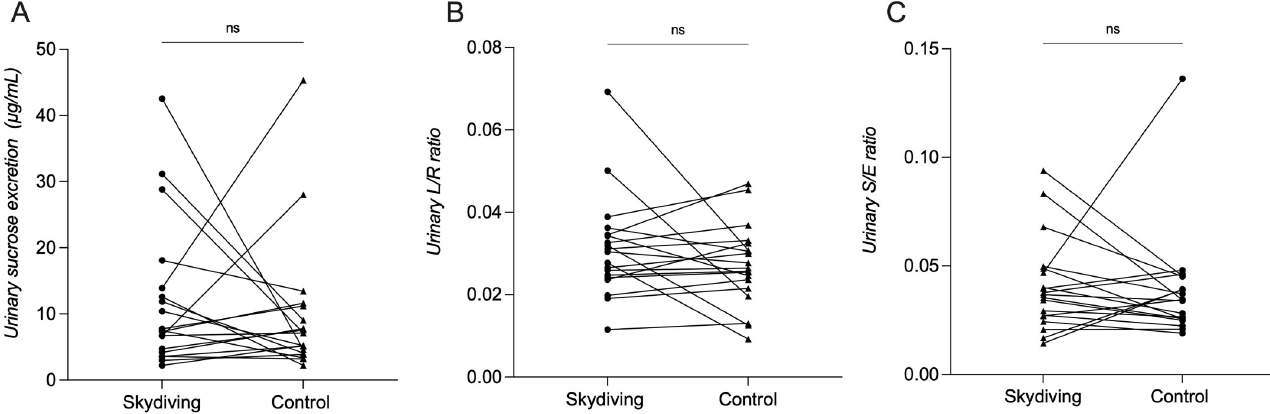
Fig 2. Intestinal permeability at the different test conditions. (A) Gastroduodenal permeability measured by urinary sucrose excretion (0-5h). (B) Small intestinal permeability measured by lactulose/rhamnose (L/R) ratio (0-5h). (C) Colonic permeability measured by urinary sucralose/erythritol (S/E) ratio (5h- 24h). There was no significant difference among the test conditions.